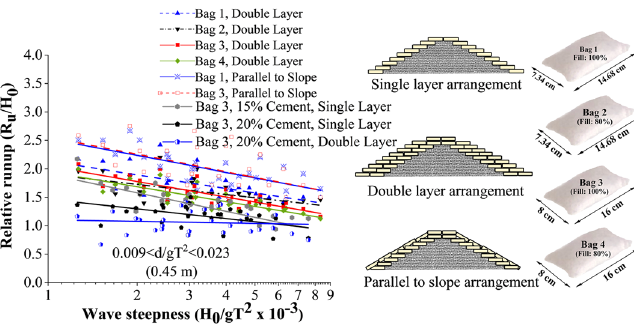
Figure 17. Comparative analysis of runup behaviour of all the tested configurations.